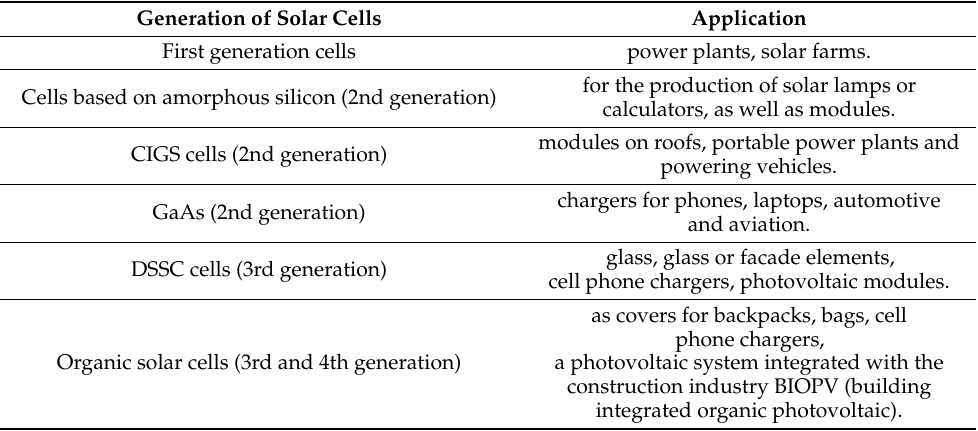
Table 5. Examples of the applications of the first to fourth generation of solar